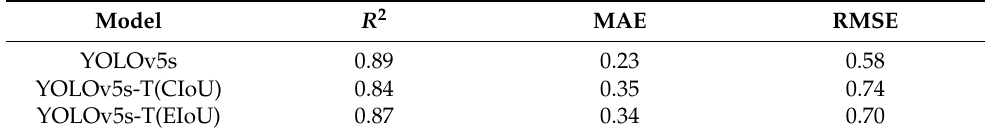
Table 3. Comparison of wheat spikelet counting performance between different models.